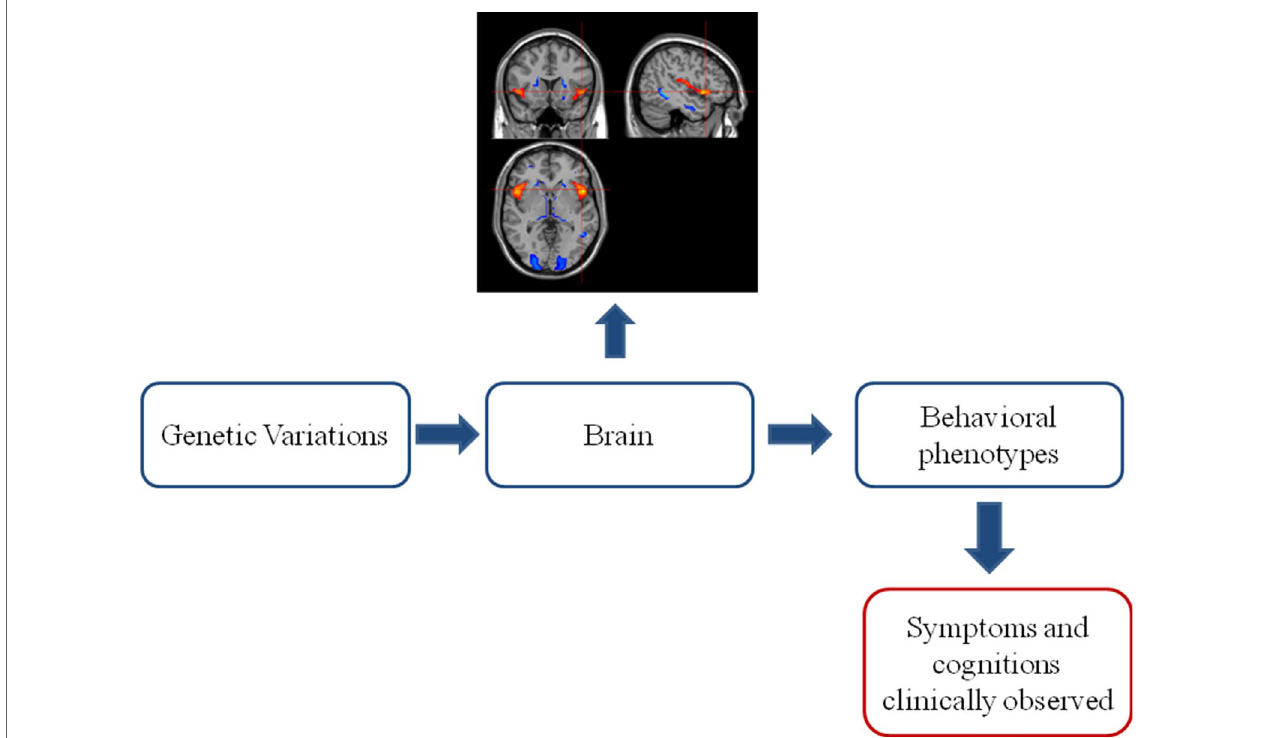
FIGURE 1 | The classic “bottom–up” model in imaging genetics. Genetic variations acclimate their influences on the brain. The brain alterations further develop into behavioral phenotype changes, which can be clinically observed as symptoms and cognitive impairments. This observed clinical profile established the base of current phenomenological diagnostic system of psychiatric